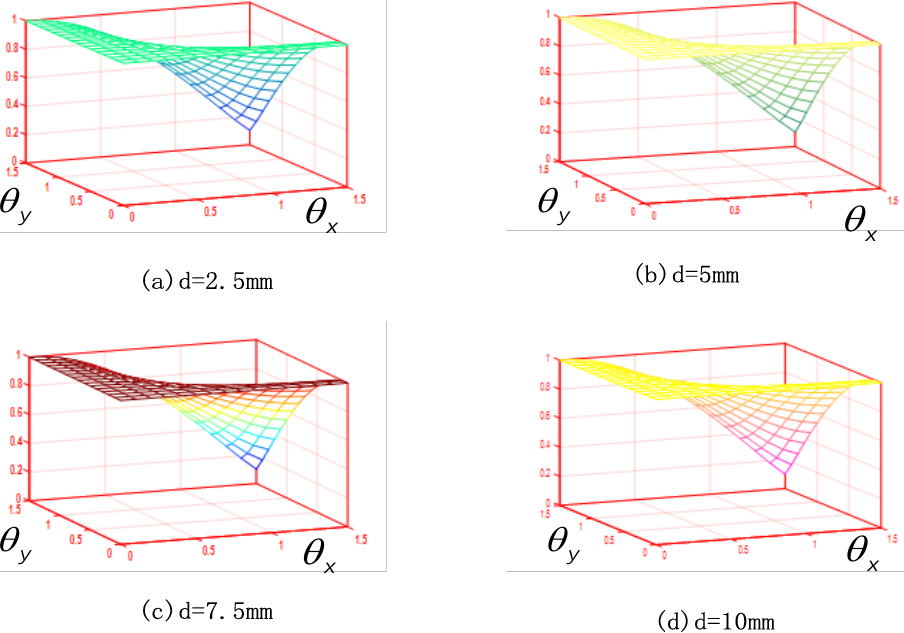
. ( a ) d = 2.5 mm; ( b ) d = 5.0 mm; ( c ) d = 7.5 mm; ( d ) d 𝑑 ′